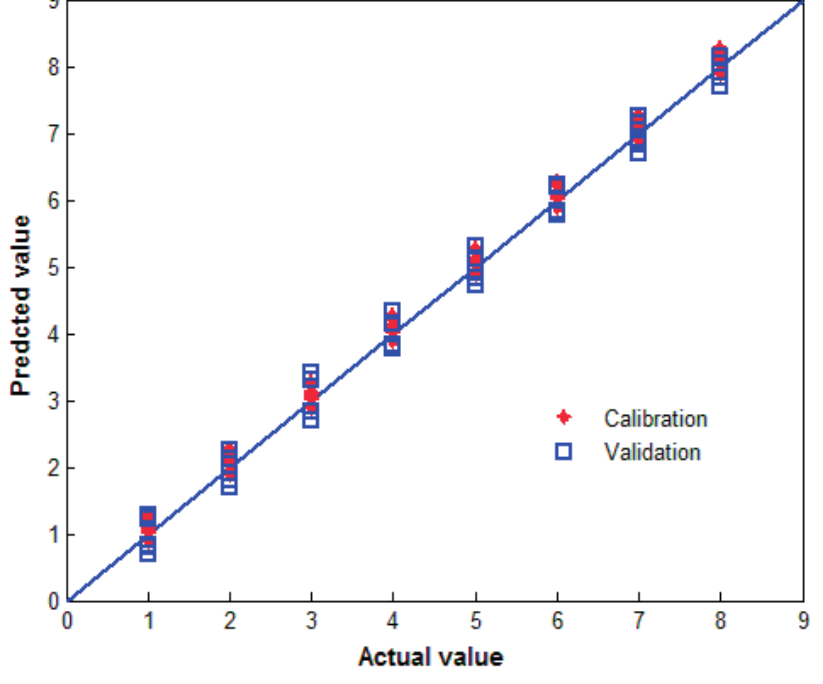
Figure 4. The calibration and validation results for wheat discrimination using the PLS